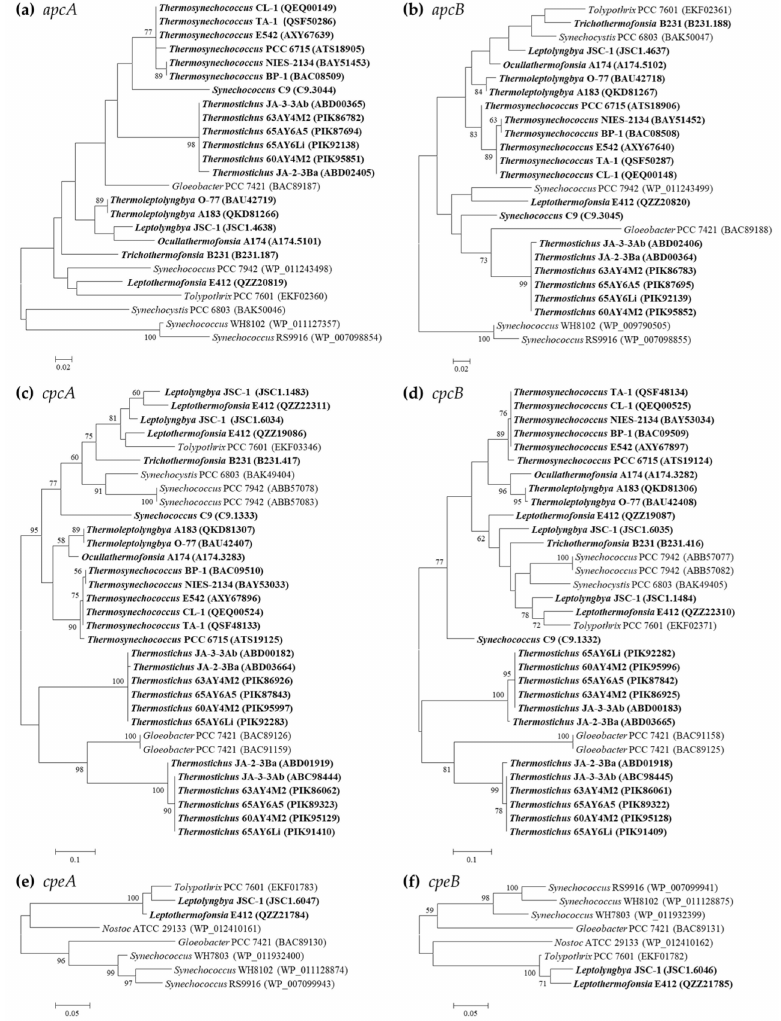
Figure 1. Phylogenetic inference of protein sequences encoding PBP subunits. The thermophilic cyanobacteria surveyed in this study are indicated in bold. Only bootstrap values > 50% are indicated at nodes. ( a ) apcA , ( b ) apcB , ( c ) cpcA , ( d ) cpcB , ( e ) cpeA , ( f ) cpeB